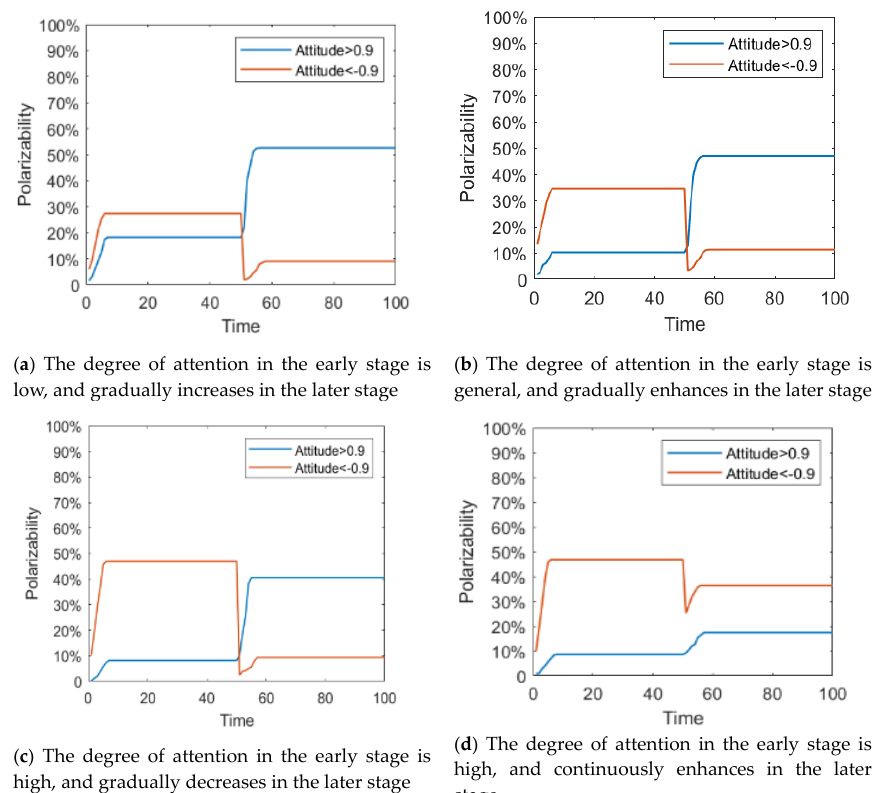
Figure 12. Curve of group attitude polarization with changes of individual attention. ( a ) The degree of attention in the early stage is low, and gradually increases in the later stage; ( b ) The degree of attention in the early stage is general, and gradually enhances in the later stage; ( c ) The degree of attention in the early stage is high, and gradually decreases in the later stage; ( d ) The degree of attention in the early stage is high, and continuously enhances in the later stage. 4.3. The Influence of Individual Conservation and Hesitation on the Process of Public Opinion Reversal Due to great differences in personality, behavioral willingness and other aspects, individuals will have different acceptance of new matters, information and ideas. Therefore, the reasons for individual attitude changes can be further explained through individual psychological conservation and hesitation, and then the internal motivation influencing public opinion reversal can be analyzed. 4.3.1. The Influence of Static Distribution of Individual Conservation on the Process of Public Opinion Reversal